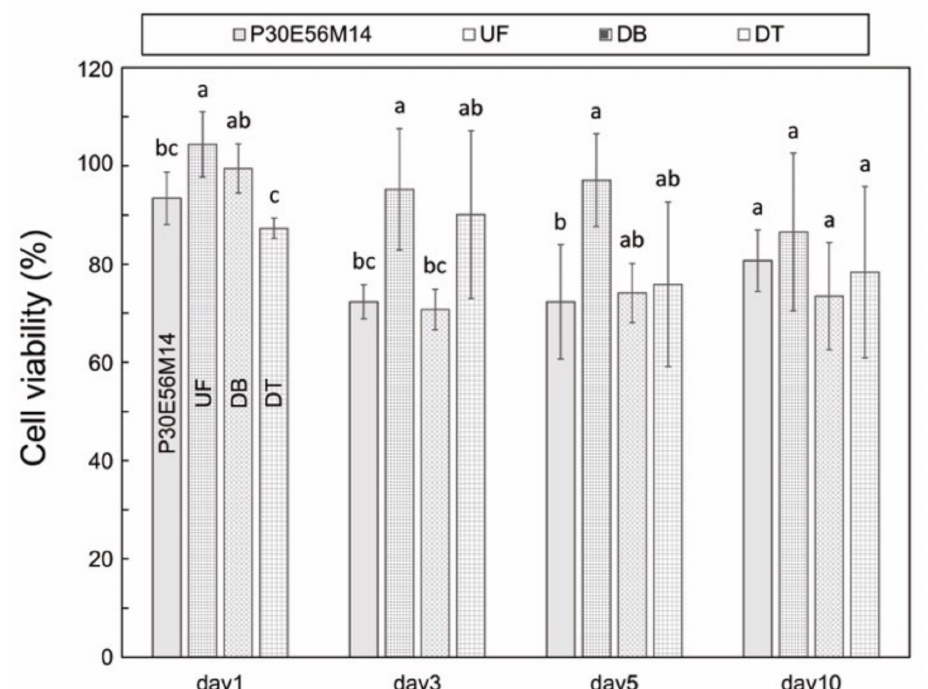
Figure 7. Cell viability in proliferation at specific days (1, 3, 5, and 10) of the printable PMMA-based resin P30E56M14, conventional PMMA (UF), and commercial 3D-print resins (DB and DT). The different letters indicate significant differences between the groups in each day ( p < 0.05, Tukey’s test, n =